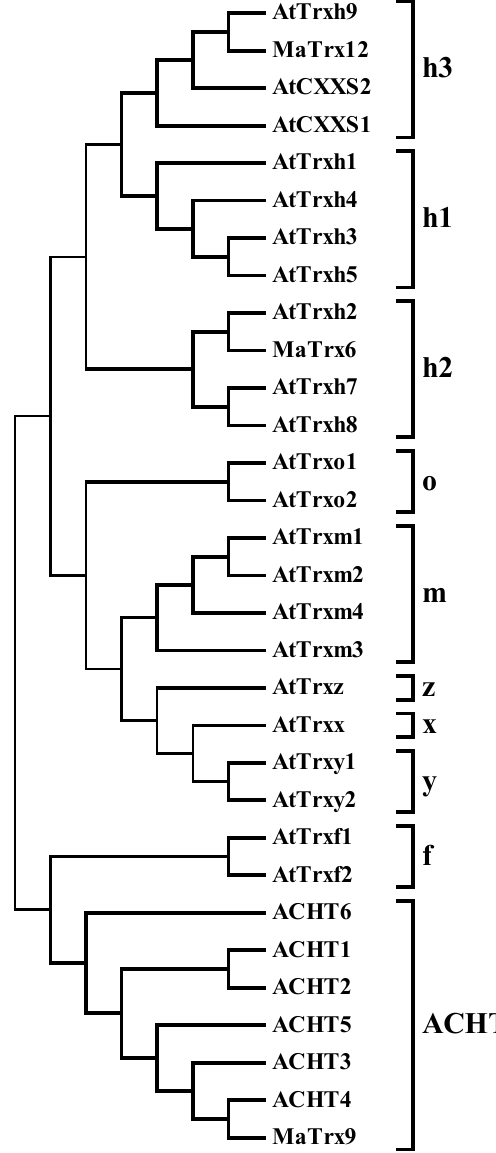
Figure 2. Phylogenetic tree of MaTrx6, MaTrx9 and MaTrx12 grouped with different types of Arabidopsis thaliana Trxs. Members of different subgroup of Trx were clustered, and the AGI numbers corresponding to each protein were AT3G51030 (h1), AT5G42980 (h3), AT1G19730 (h4), AT1G45145 (h5), AT5G39950 (h2), AT1G59730 (h7), AT1G69880 (h8), AT3G08710 (h9), AT1G11530